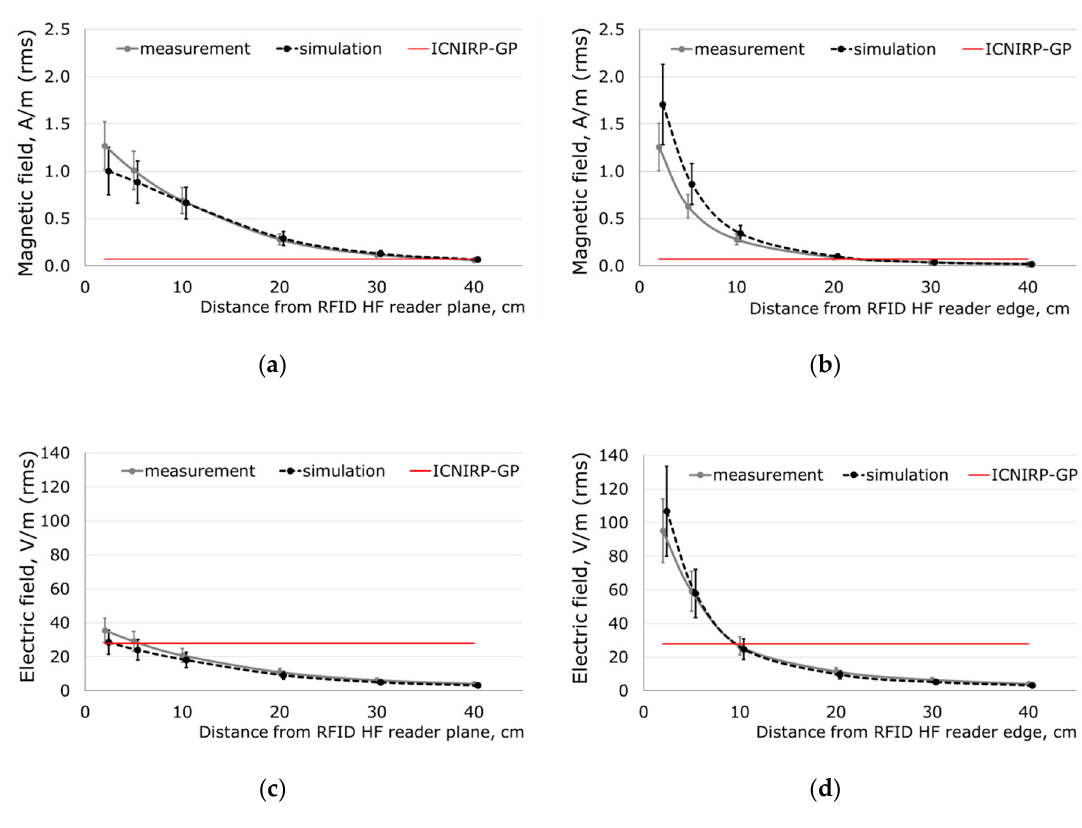
Figure 3. The EMF distribution in the function of distance from an RFID HF reader with a reading range of 30 cm measured by NBM 550 meter and simulated by CST Studio Suite: magnetic field along the axis perpendicular to the reader plane ( a ) and ( b ) along the axis perpendicular to the reader edge, ( c ) electric field along the axis perpendicular to the reader plane, and ( d ) along the axis perpendicular to the reader edge (whiskers—range of values due to uncertainty of measurements or simulations (K = 1); ICNIRP–GP—reference level (limit) for general public exposure; distance from an RFID reader to the center of the measurement probe; results at 2 cm and 5 cm away were extrapolated on the basis of measurements at 10–40 cm away from the reader.